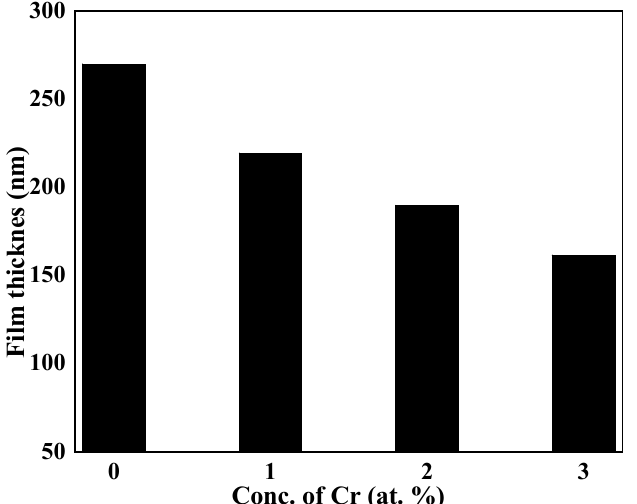
Figure 1. Variation in thickness versus concentration of dopant of undoped and Cr-doped Bi 2 S 3 thin films.